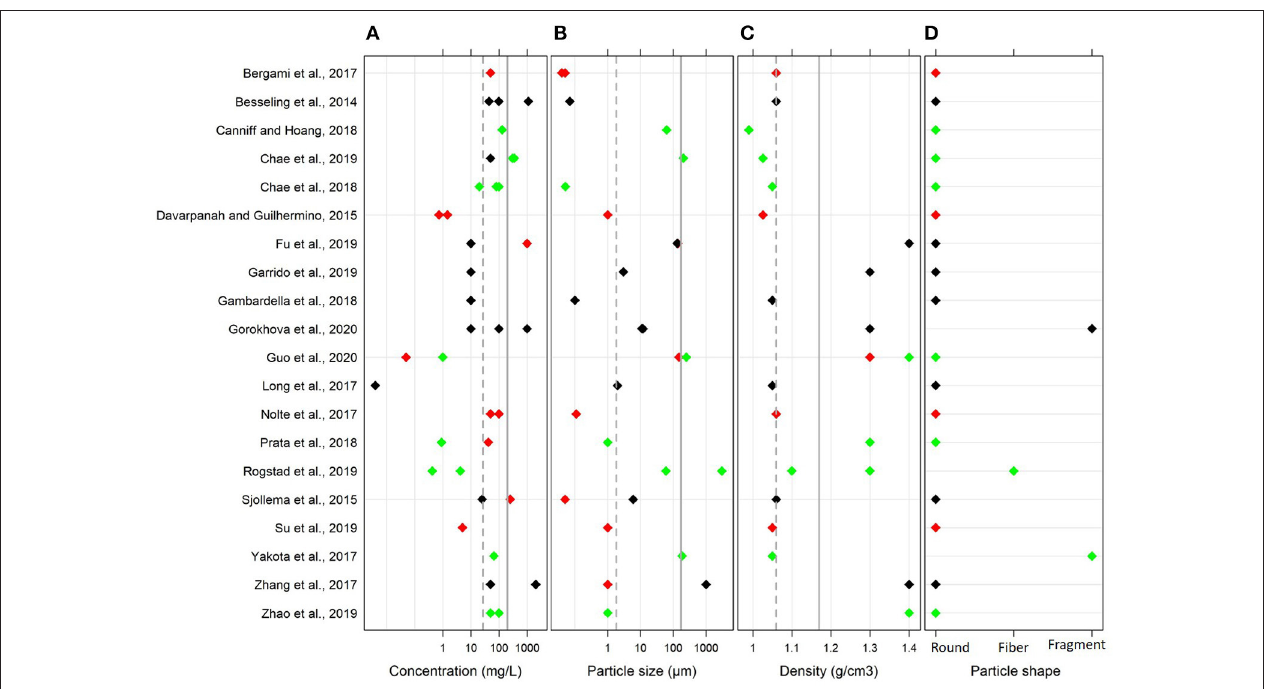
FIGURE 2 | Variability of the main parameters in the global dataset used in the meta-analysis: (A) MNP concentration (mg/L), (B) particle size ( µ m), (C) polymer density (g/cm 3 ), and (D) particle shape. The mean and median values are shown by solid and dotted lines, respectively. The effects on algal growth reported by the authors in each study are indicated by the color coding; red, negative effect; black, no effect; and green, positive effect. Note logarithmic scale on the x axes for (A,B)